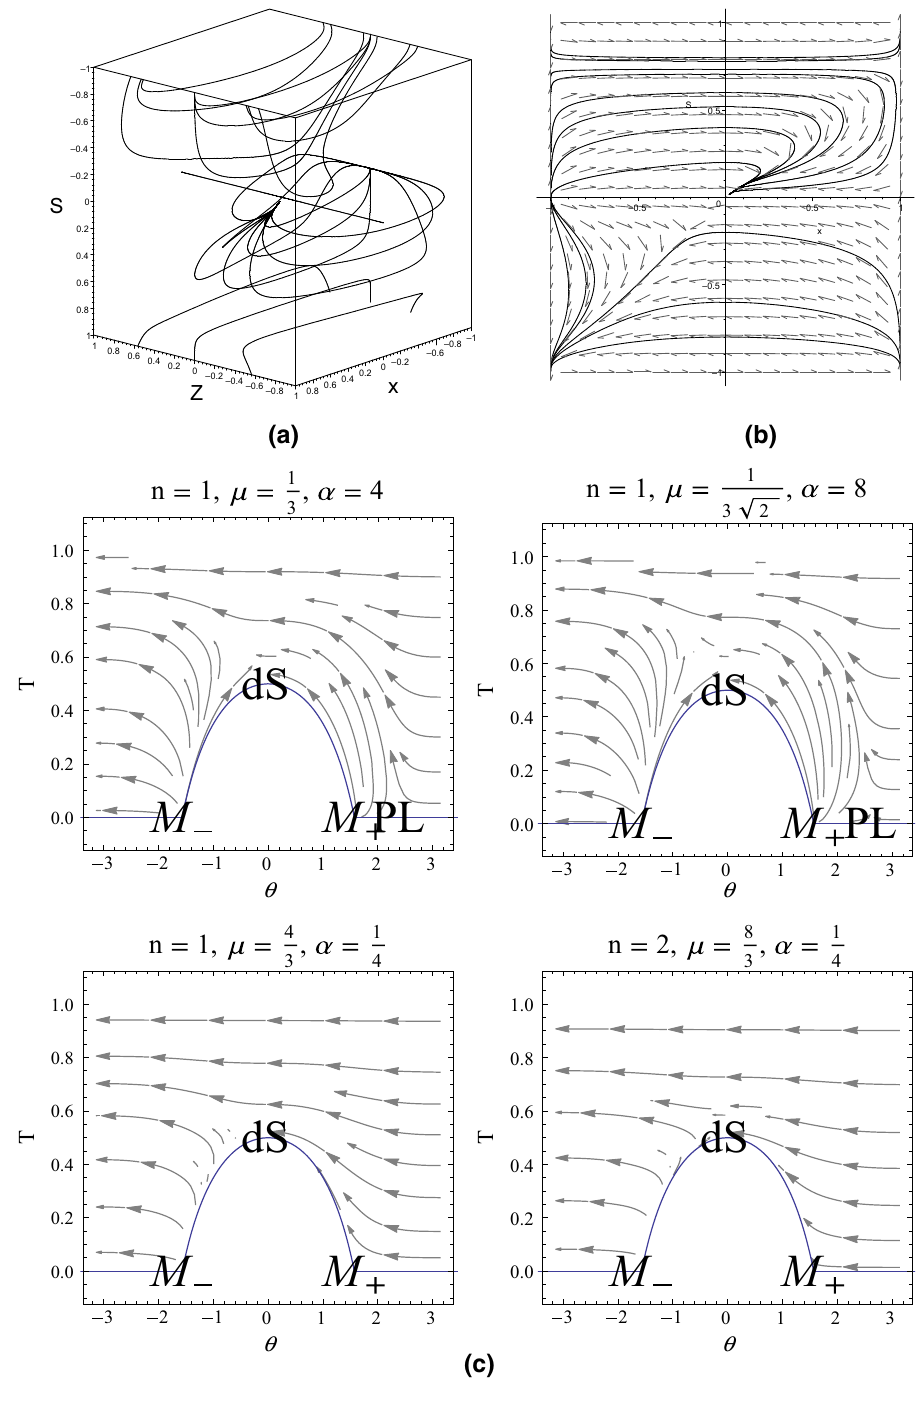
Fig. 3 a Compact